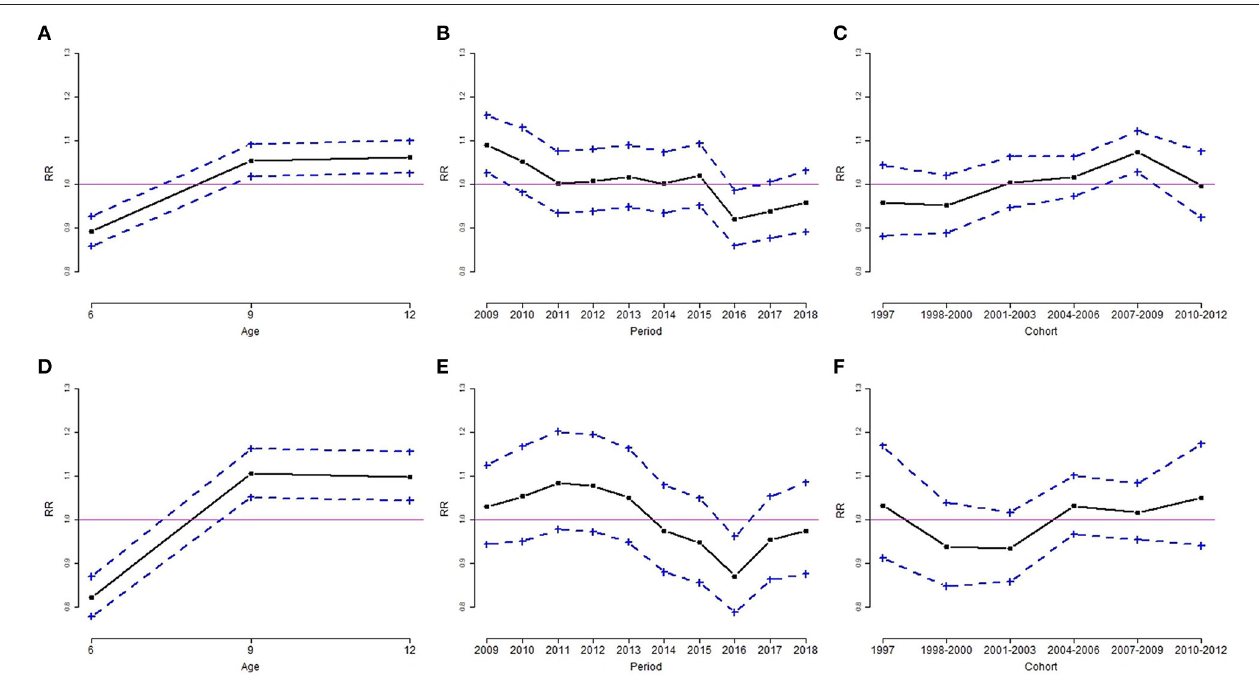
FIGURE 3 | Age, period, and cohort effect of the rate ratio (RR) of overweight by sex group, for boys (A–C) and girls (D–F) . (A,D) : age effect; (B,E) : period effect; (C,F) : cohort effect. Results are RR (solid line) and 95% confidence interval (dotted line). The solid horizontal line represents RR = 1.